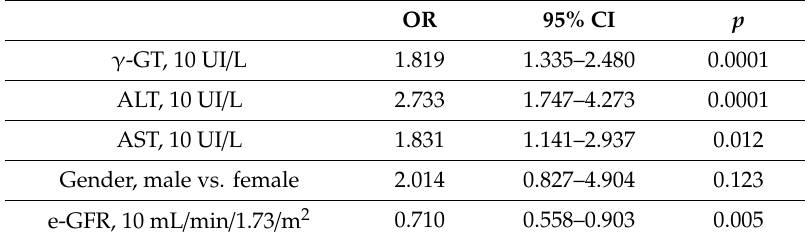
Table 6. Multiple logistic analysis of endothelial dysfunction in Subgroup B ( n = 253).